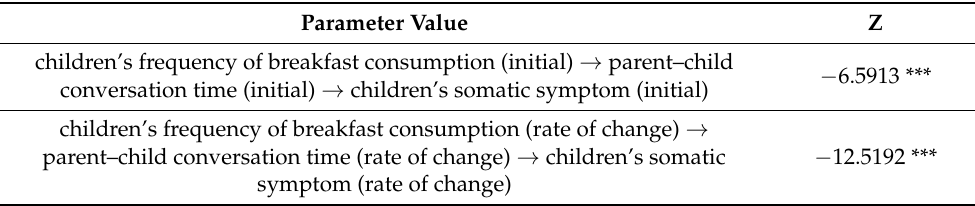
Table 7. Longitudinal mediating effect of the multivariate latent growth model (Sobel